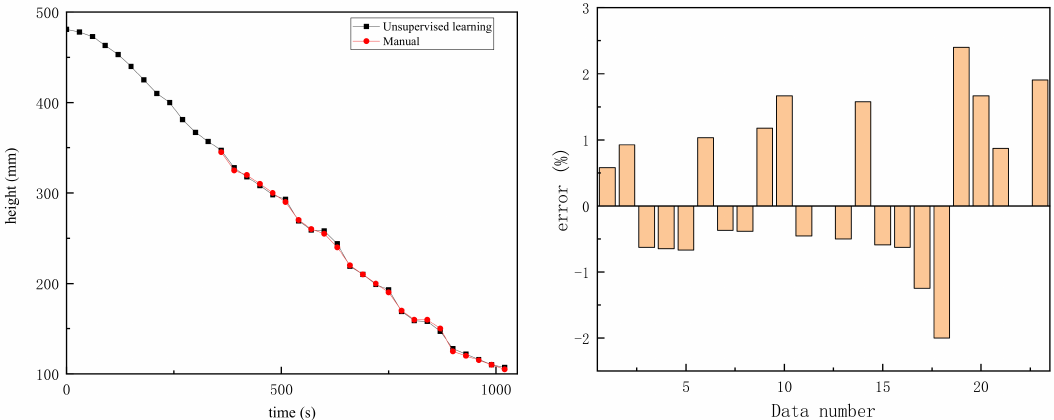
Figure 7. Comparison between the unsupervised learning recognition results and the manual recognition